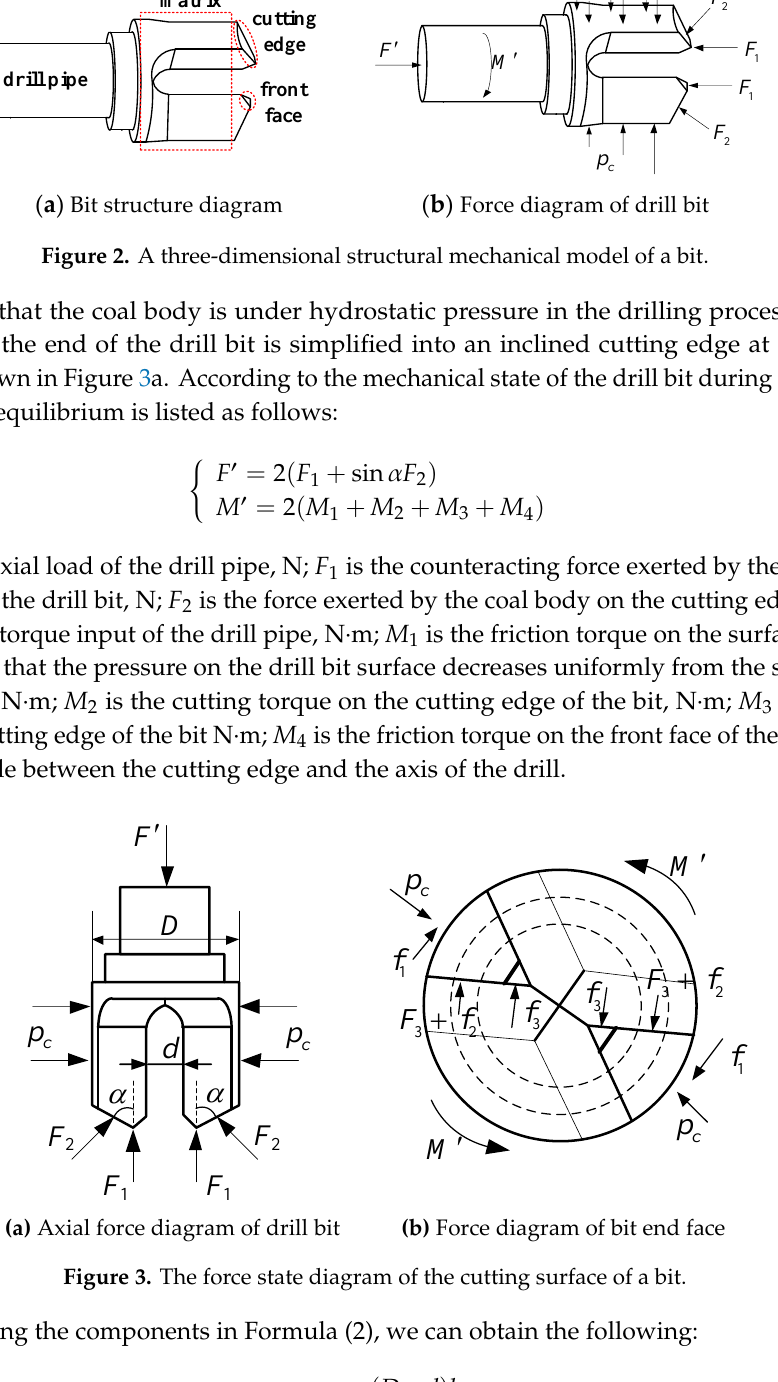
Figure 3. The force state diagram of the cutting surface of a bit.